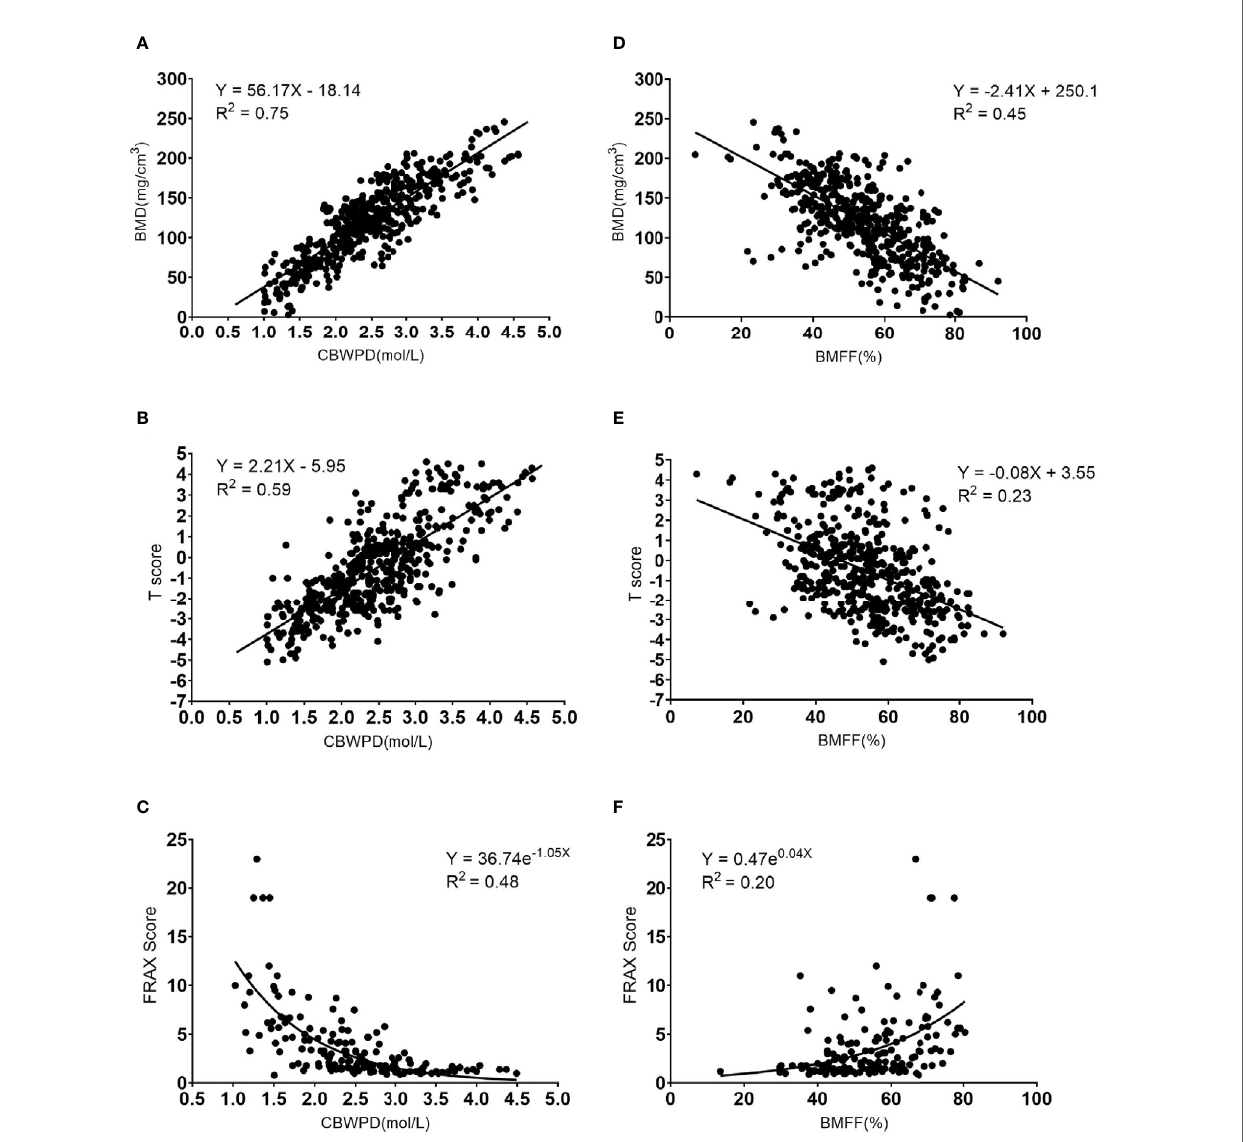
FIGURE 3 | Correlation curves and scatter plots for the measurements between (A) collagen bound water proton density (CBWPD) and bone mineral density (BMD), (B) CBWPD and T score, (C) CBWPD and Fracture Risk Assessment Tool (FRAX) score, (D) bone marrow fat fraction (BMFF) and BMD, (E) BMFF and T score, and (F) BMFF and FRAX